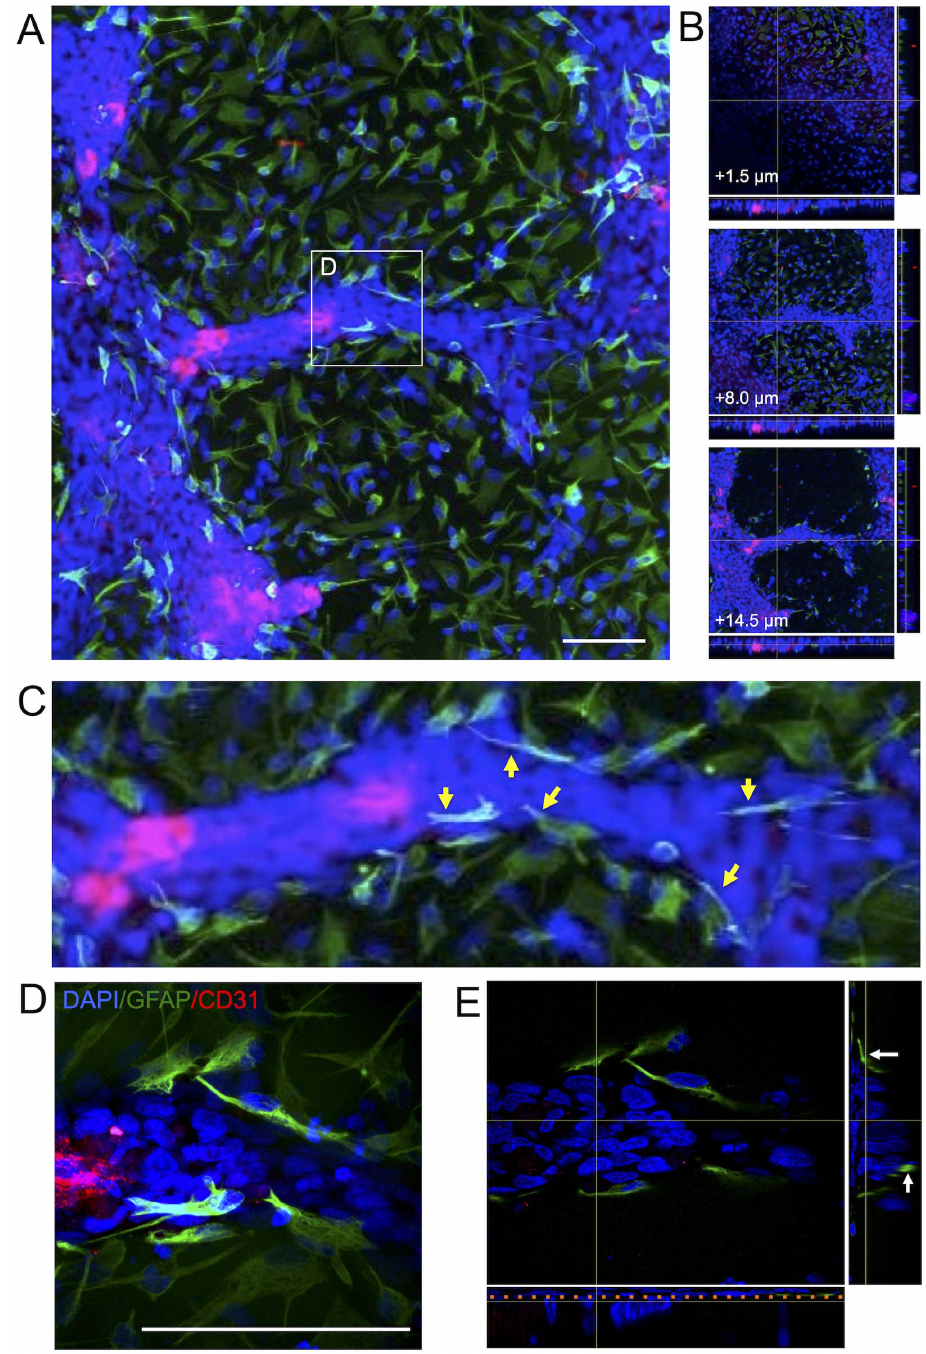
Figure 6. 3-dimensional cytoarchitecture of vasculature-like structures. (A) A 3-dimensional cytoarchitecture composed of hCMECs (CD31 + cells in red) and hNSCs (polyclonal GFAP + cells in green) was visualized using confocal microscopy. (B) At the base of the coculture, hNSCs were seen in a monolayer on which hCMECs formed VLS that was characterized by a multicellular organization that extended beyond the monolayer to form a unique structure. (C) Some hNSCs with an astrocytic phenotype were associated with these VLS by forming a layer of cells around the tubular walls in some cases with an elongated morphology and endfeet on the VLS (yellow arrows). The astrocytes were ensheathing the VLS. (D) A higher magnification 3D confocal image clearly demonstrates structural differences in astrocytes’ morphology upon interfacing with the VLS rather than being inside the neural patch. (E) A 3-dimensional cut through this area further indicates that astrocytes provide structural support (white arrows) to the VLS. The orange line indicates the monolayer formed by hNSCs onto which the VLS rests. Nevertheless, no hollow lumen is formed by the VLS. It hence here remains unclear if a 3-dimensional support structure is required to create a lumen and if they are inflatable in a flow system. Diamidino-2- phenylindole (DAPI, blue) serves as a nuclear counterstain. Scale bars represent 100 m m.